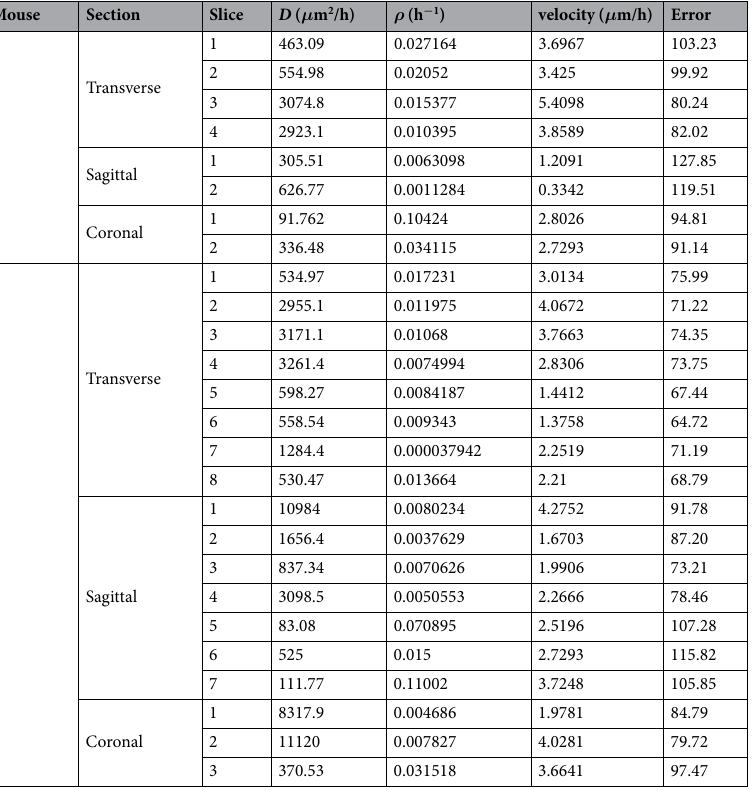
Table 4. Values of estimated parameters for Mouse 1 and 2 and Hypothesis 1 using the 2D level set method. Minimization is performed with respect to equation